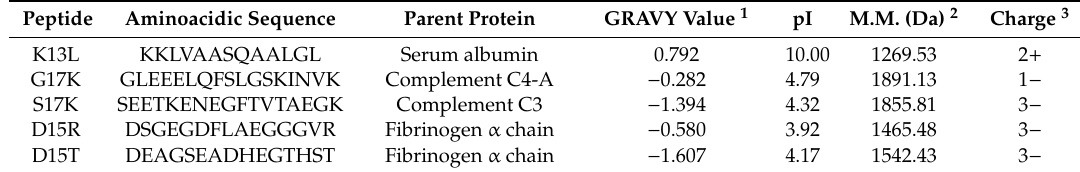
Table 1. Characteristics of selected